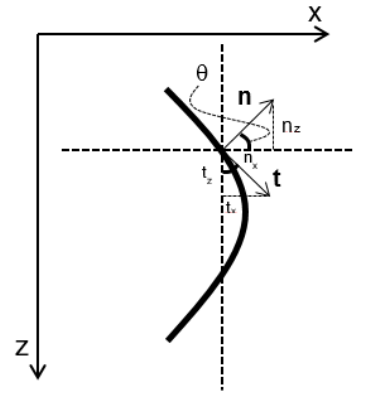
Figure A2. Wall profile and the correspondent local normal-tangent reference frame.